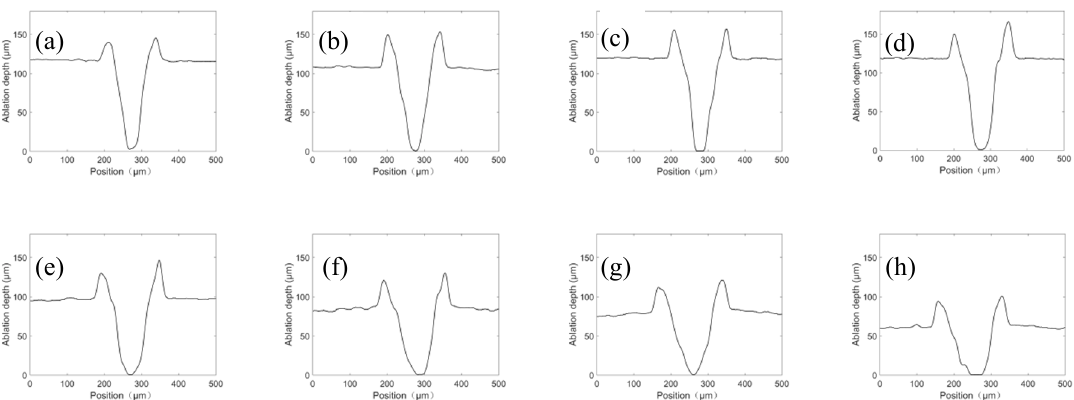
Figure 10. Ablation craters’ cross section after irradiation of 32 pulses at different substrate temperatures. (a) 50 °C; (b) 100 °C; (c) 150 °C; (d) 200 °C; (e) 250 °C; (f) 300 °C; (g) 350 °C; (h) 400 °C.